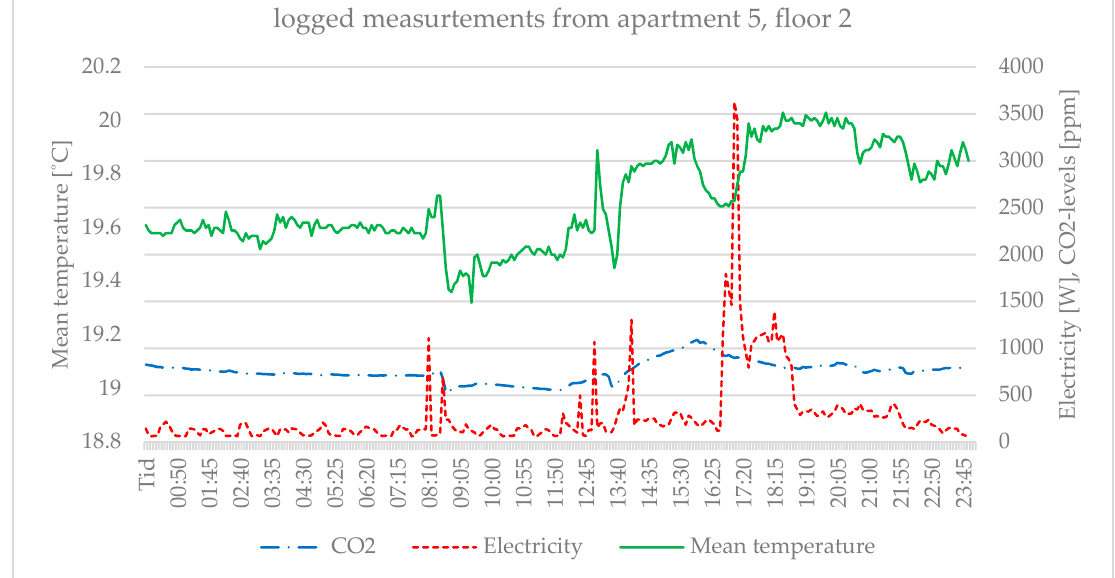
Figure 2. The logged measurements from apartment 5, second floor, on 19 November. The green (full) curve shows temperature, the blue (dotted and dashed) curve shows CO 2 level, and the red (dashed) curve shows electric power. Table 8. Transcribed time diary from tenant in apartment 5, second floor, on 19 November. The effects of entries on the gray background are clearly visible in the logged measurements in Figure 2.